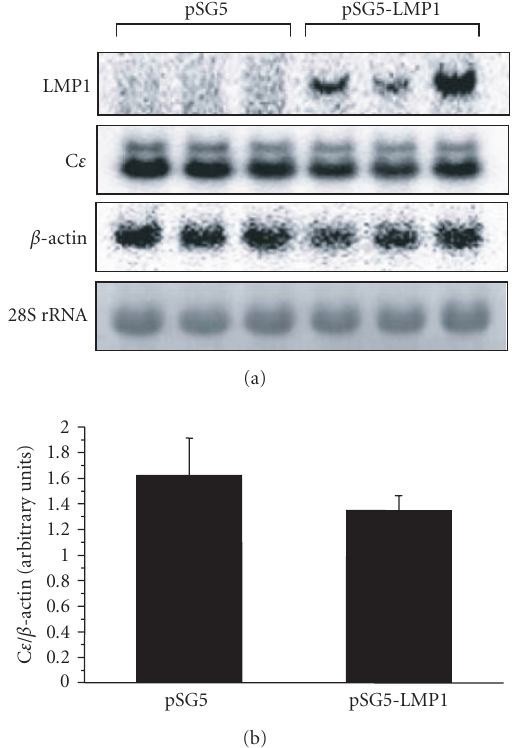
Figure 4: E ff ect of LMP1 expression on C ε mRNA levels of IgE- producing hybridoma FE-3 cells. The pSG5-LMP1 or empty vec- tor was transfected into IgE-producing hybridoma FE-3 cells using lipofection method. (a) LMP1 and C ε mRNA expressions were de- termined by Northern blot analysis as described in the “materials and methods.” The results of three independent experiments are shown. (b) C ε mRNA levels are represented by the values normal- ized to the intensity of PCR products for β -actin. Data are expressed as means ± SD of six independent